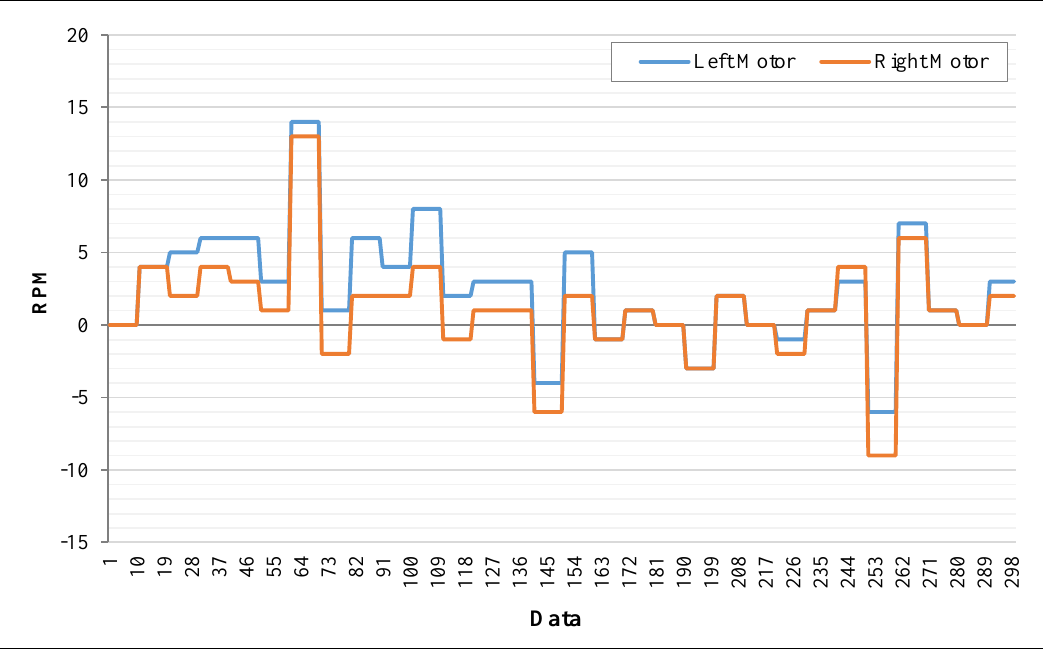
Figure 18. Motor speed response system with PID